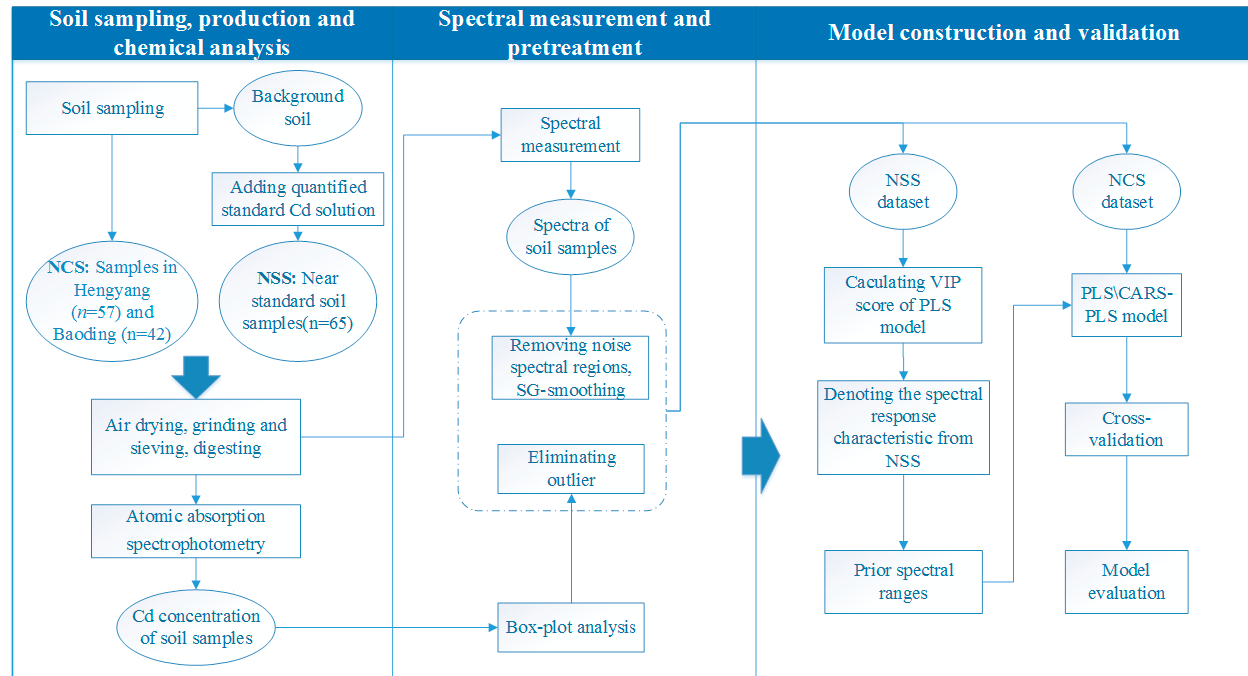
Figure 1. Flow chart of Cd concentration prediction based on NCS enhanced by prior spectral bands extracted from NSS Cd .